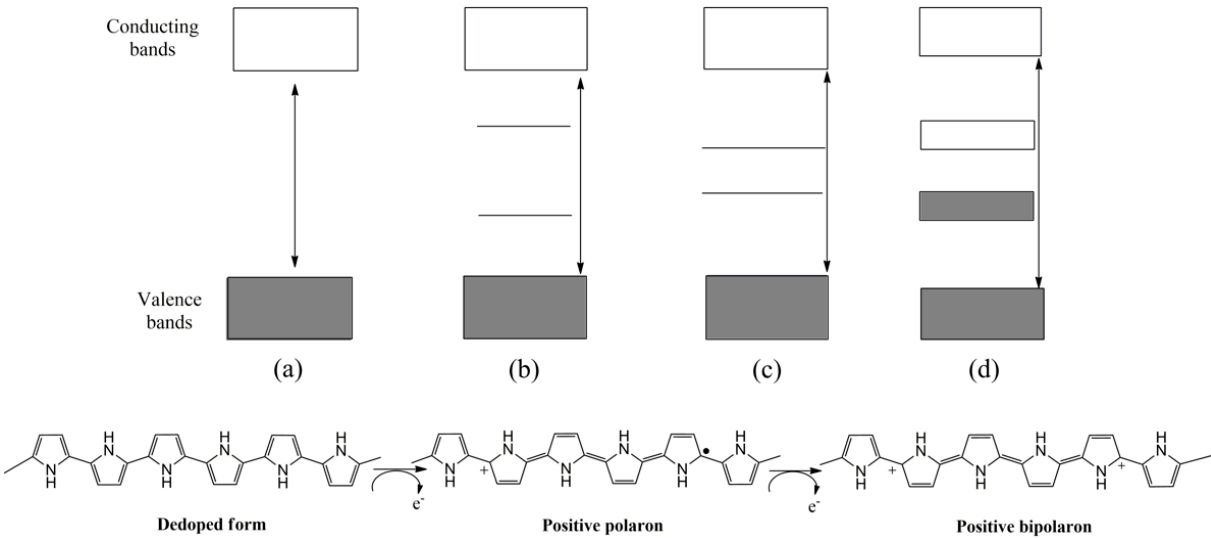
Figure 1. Schematic representation of p-doping process of PPy and structure of electronic bands in different electronic states: ( a ) de-doped, ( b ) polaron, ( c ) bipolaron, ( d ) bipolaron coupling.